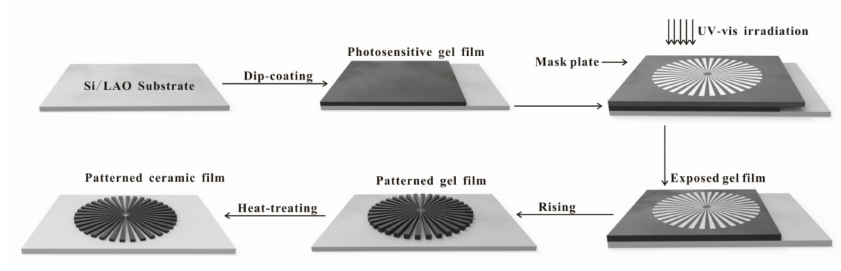
Figure 1. Preparation flowchart of the micro-patterned CaMn 7 O 12 ceramic